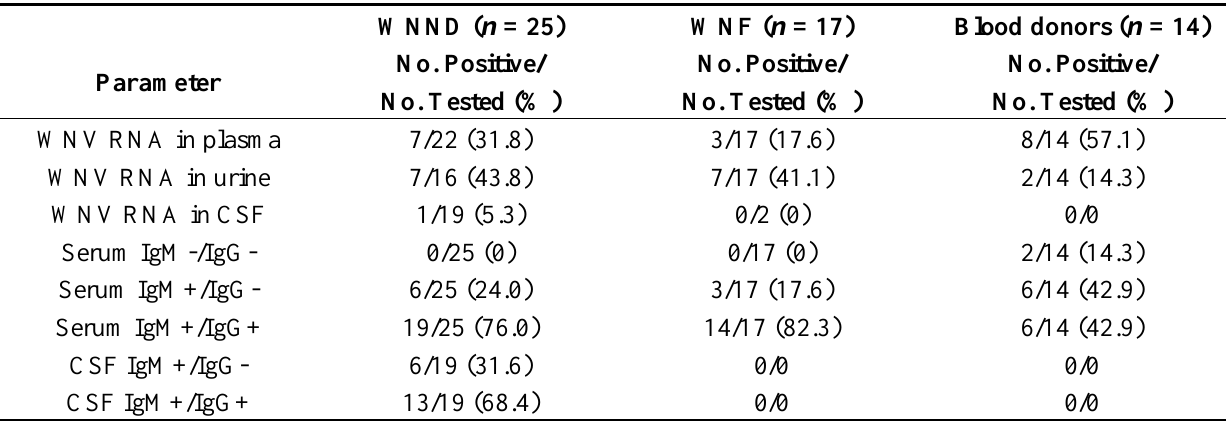
Table 2. Summary of the results of virological tests performed in confirmed cases of WNV infection, Northeastern Italy, 2012. (minus sign or not? OK, it is minus